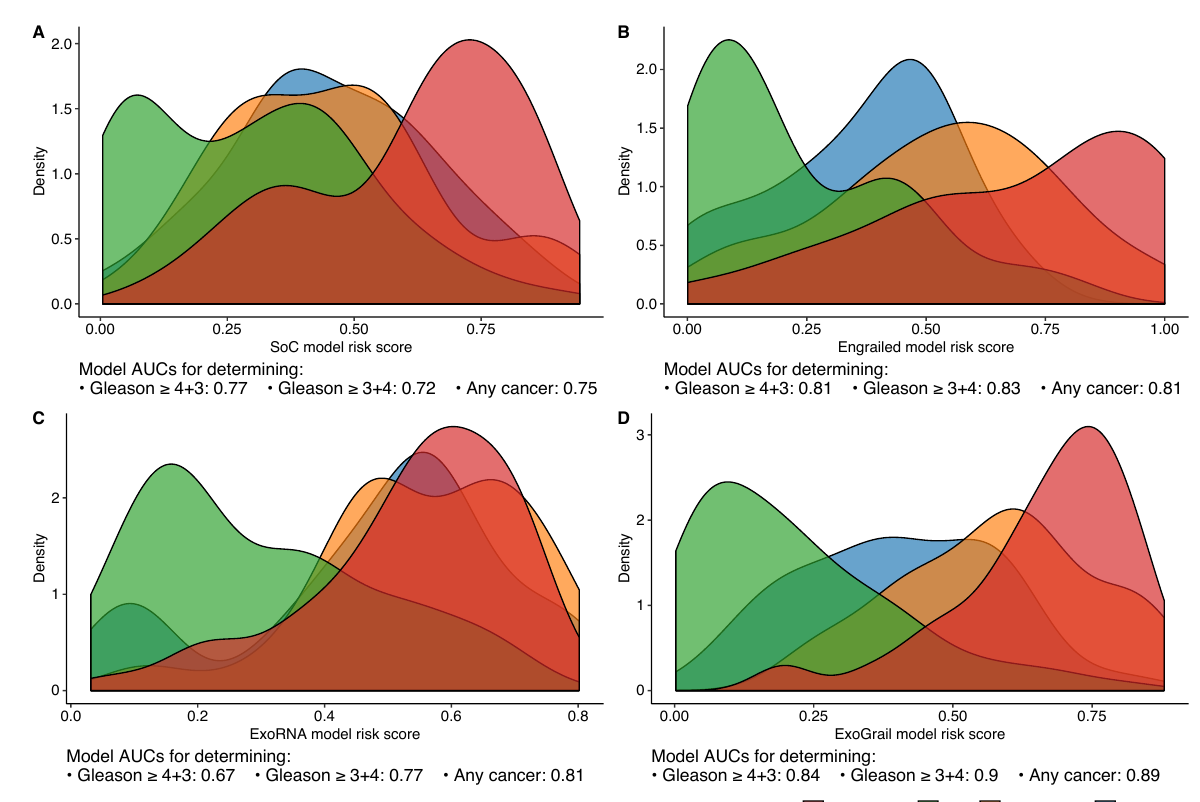
Figure 3. Risk score distributions of the four trained models, calculated as the out-of-bag predictions and represented as density plots. Area under the receiver operator curves (AUCs) for each model’s predictive ability for clinically relevant outcomes are detailed underneath each panel. Each random forest model was fit using different input variables; ( A ) SoC clinical risk model, including Age and serum prostate specific antigen (PSA), ( B ) Engrailed model, ( C ) ExoRNA model and ( D ) ExoGrail model, combining predictors from all three modes of analysis. The full list of variables in each model is available in Table 1. Fill colour shows the risk score distribution of patients with respect to biopsy outcome: No evidence of cancer (Green), Gleason 6 (Blue), Gleason 3 + 4 (Orange), Gleason ≥ 4 + 3